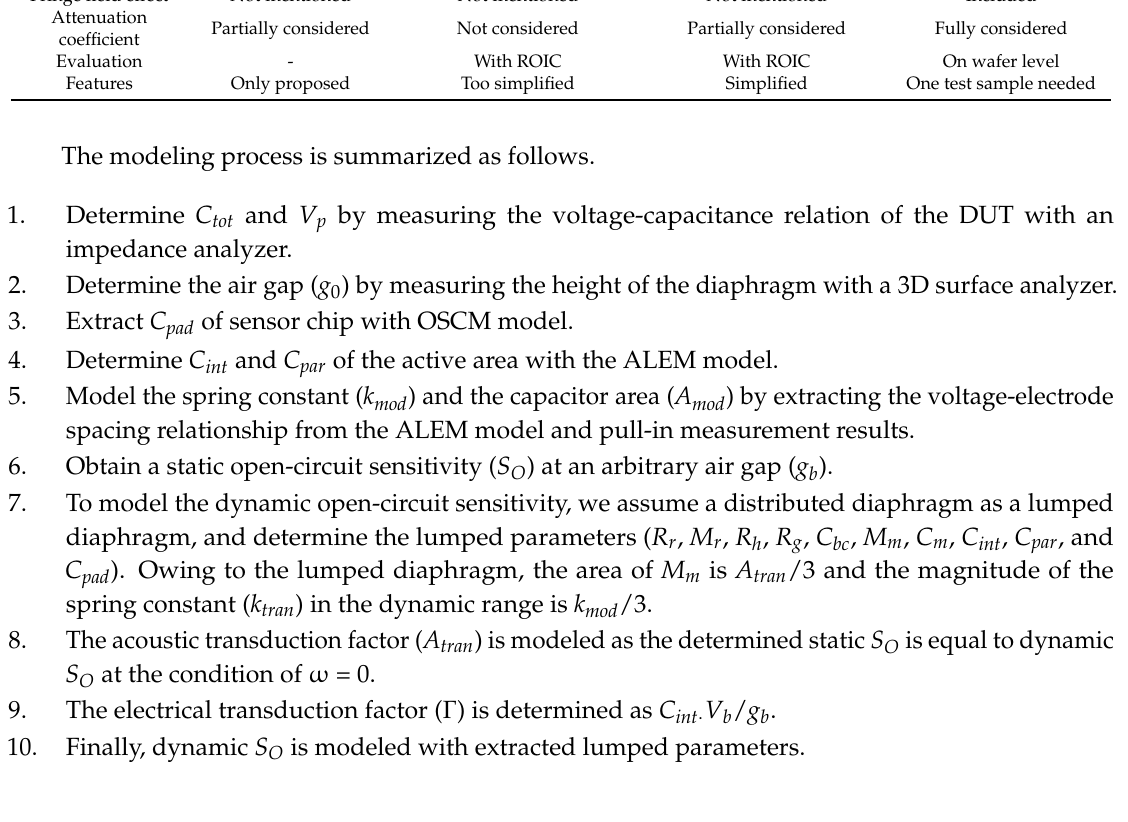
Table 1 . Comparisons between the proposed study and the currently published models.